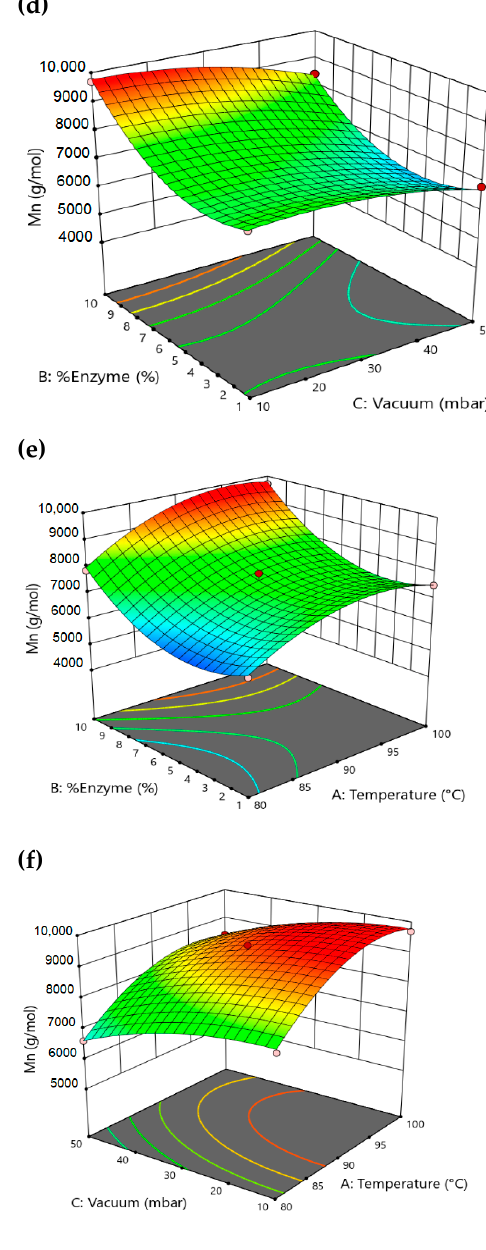
Figure 2. ( a ) E ff ect of vacuum and temperature on M n (solution) at 10% enzyme loading. ( b ) E ff ect of vacuum and % enzyme loading on M n (solution) at 100 ◦ C. ( c ) E ff ect of % enzyme loading and temperature on M n (solution) at 10 mbar of reduced pressure. ( d ) E ff ect of vacuum and % loading enzyme on M n (bulk conditions) at 100 ◦ C. ( e ) E ff ect of % enzyme loading and temperature on M n (bulk conditions) at 10 mbar of vacuum. ( f ) E ff ect of vacuum and temperature on M n (bulk conditions) at 10% enzyme loading. (The red and pink points represent experimental data above and below the predicted model,